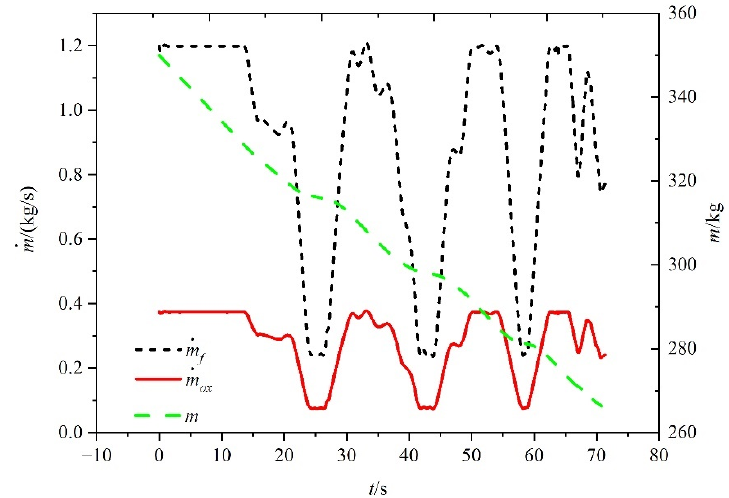
Figure 16. Propellant mass flow rates and vehicle mass under case 1 in the third scenario vs. time.